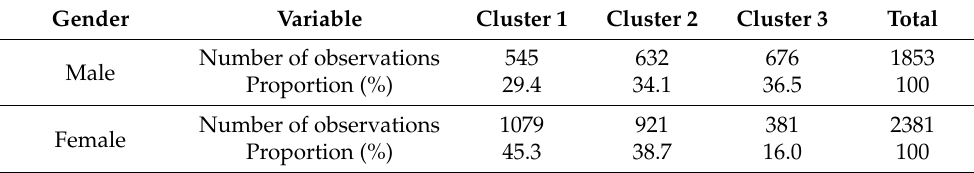
Table 4. Number of observations and the proportion (%) of males and females in each